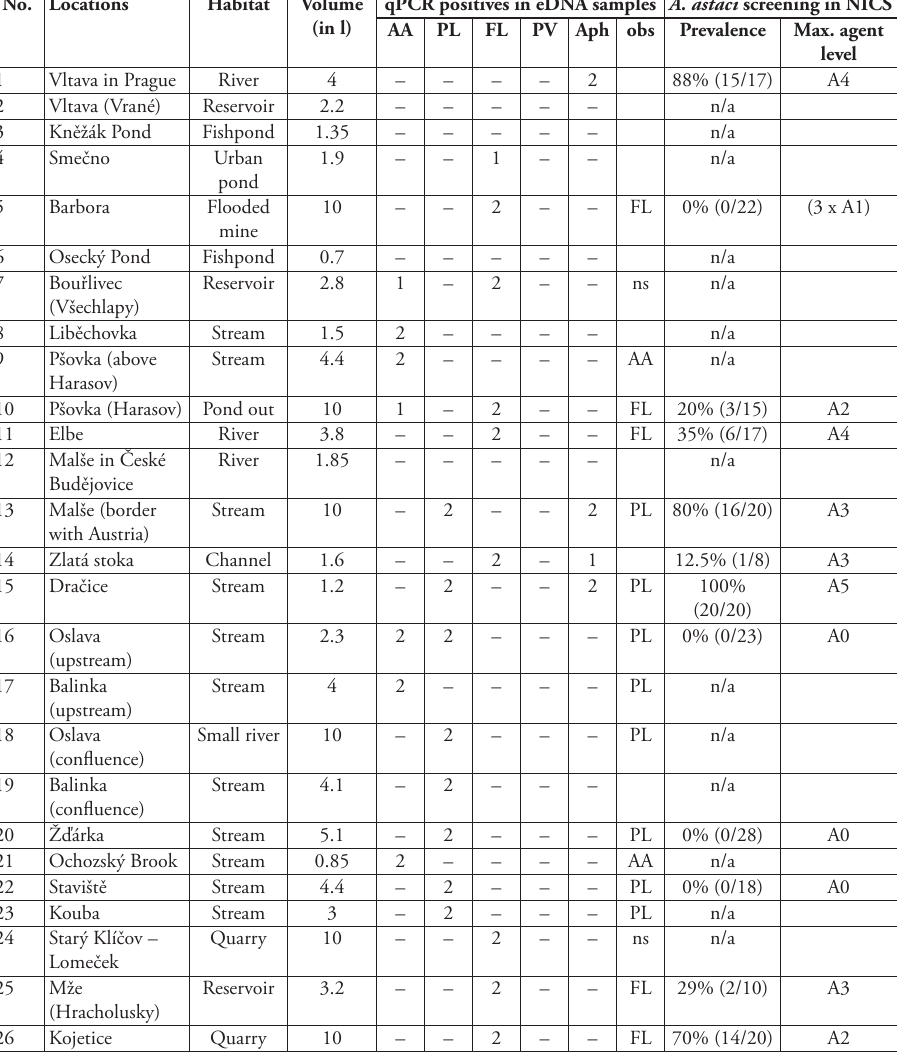
table 2. Results of the eDNA analyses from individual sampling sites. Volumes of water filtered (in l) indicated. The target species are abbreviated as follows: AA for Astacus astacus (noble crayfish), PL for Pacifastacus leniusculus (signal crayfish), PV for Procambarus virginalis (marbled crayfish), FL for Faxonius limosus (spiny-cheek crayfish) and Aph for Aphanomyces astaci (crayfish plague agent). The column labelled “obs” indicates any crayfish observed at the respective site during the sampling, using the same species abbreviations. Sites where manual search for crayfish was impossible to conduct are indicated by “ns”. Detection in eDNA samples is stated as unambiguous confirmation on 0 (marked as “–“), 1 or 2 filters per site (for more details, see Suppl. material 4: Table S4). The prevalence of A. astaci in NICS popula- tions and maximum agent level in infected crayfish following Vrålstad et al. (2009) is specified. For more details about the sampling sites and specific comments, including past evidence of crayfish presence, see Suppl. material 1: Table